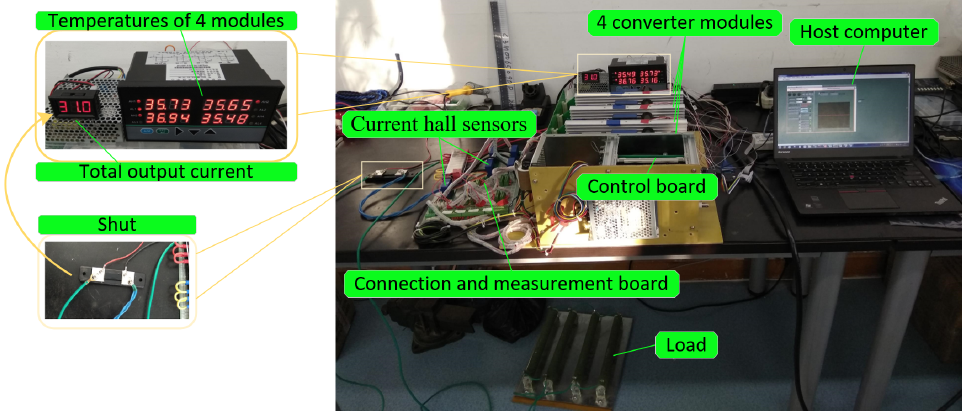
Figure 20. 3 + 1 modules charging system experimental platform.